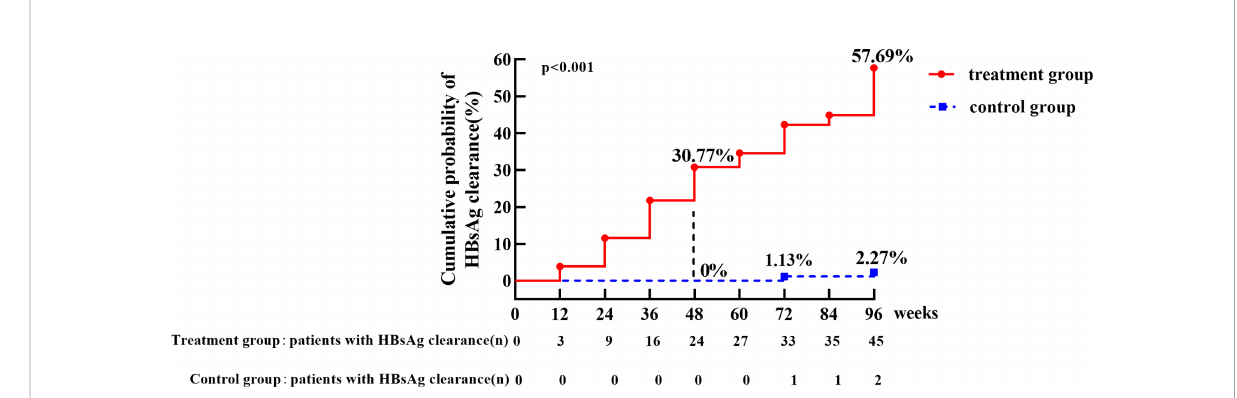
FIGURE 2 The cumulative incidence of HBsAg clearance in treatment group and control group. The cumulative rate of HBsAg clearance at week 48 was 30.77% in treatment group versus 0% in the control group, respectively. The cumulative incidence of HBsAg clearance was 57.69% in treatment group, which was signi fi cantly higher than control group (2.27%) at week 96, p <